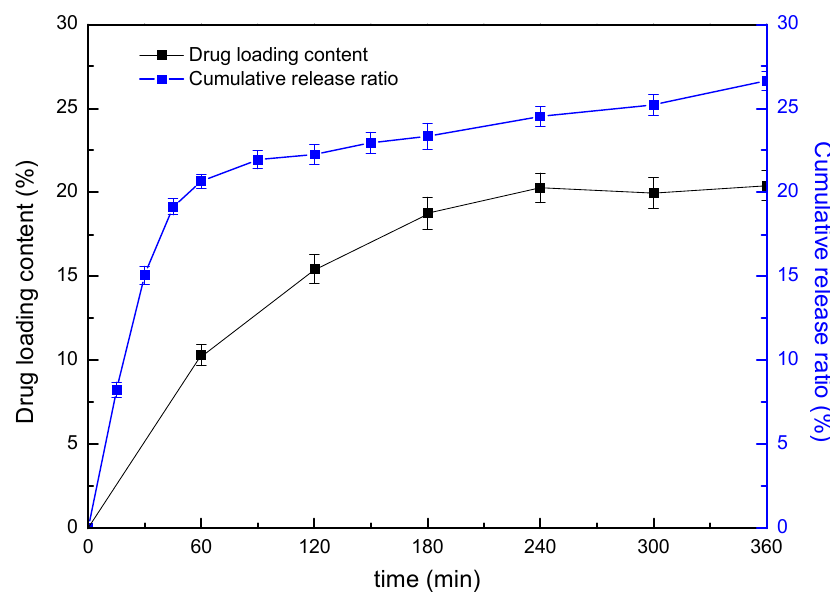
Figure 5. Effect of time on the drug loading content and cumulative release ratio.